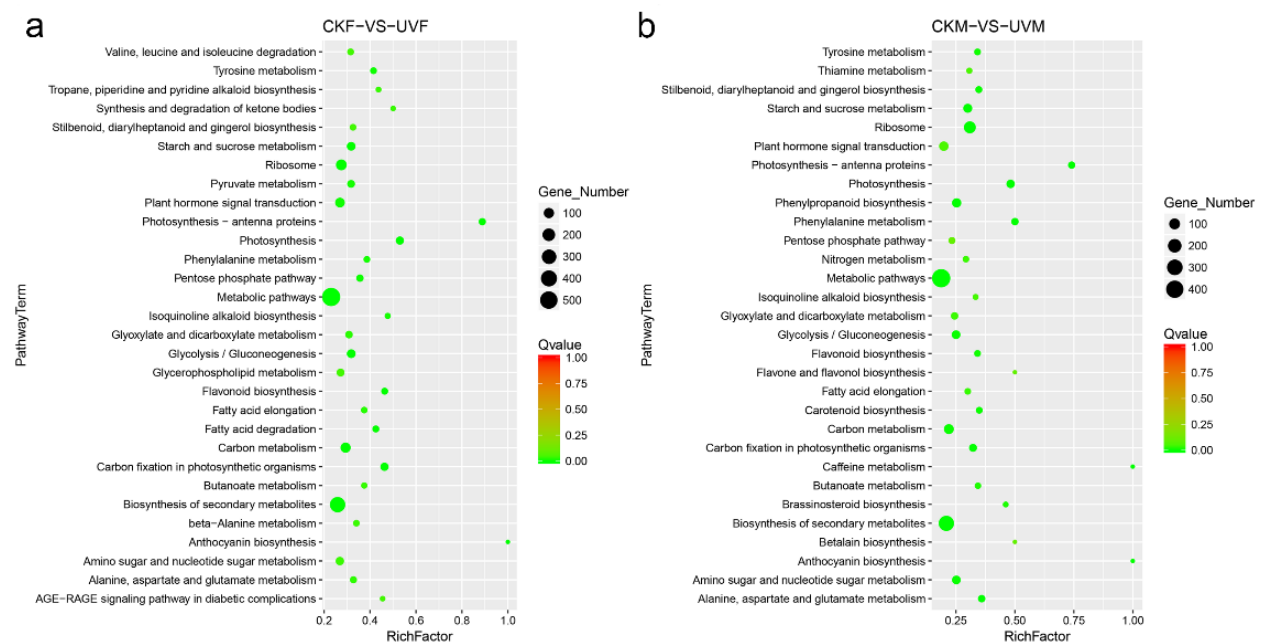
Figure 5. KEGG pathway enrichment analysis of the DEGs detected in the CKF vs. UVF ( a ) and the CKM vs. UVM ( b ) comparisons. The significance of the enriched pathways is based on q values < 0.05. Rich Factor is the ratio of DEGs to the total number of genes in each pathway.